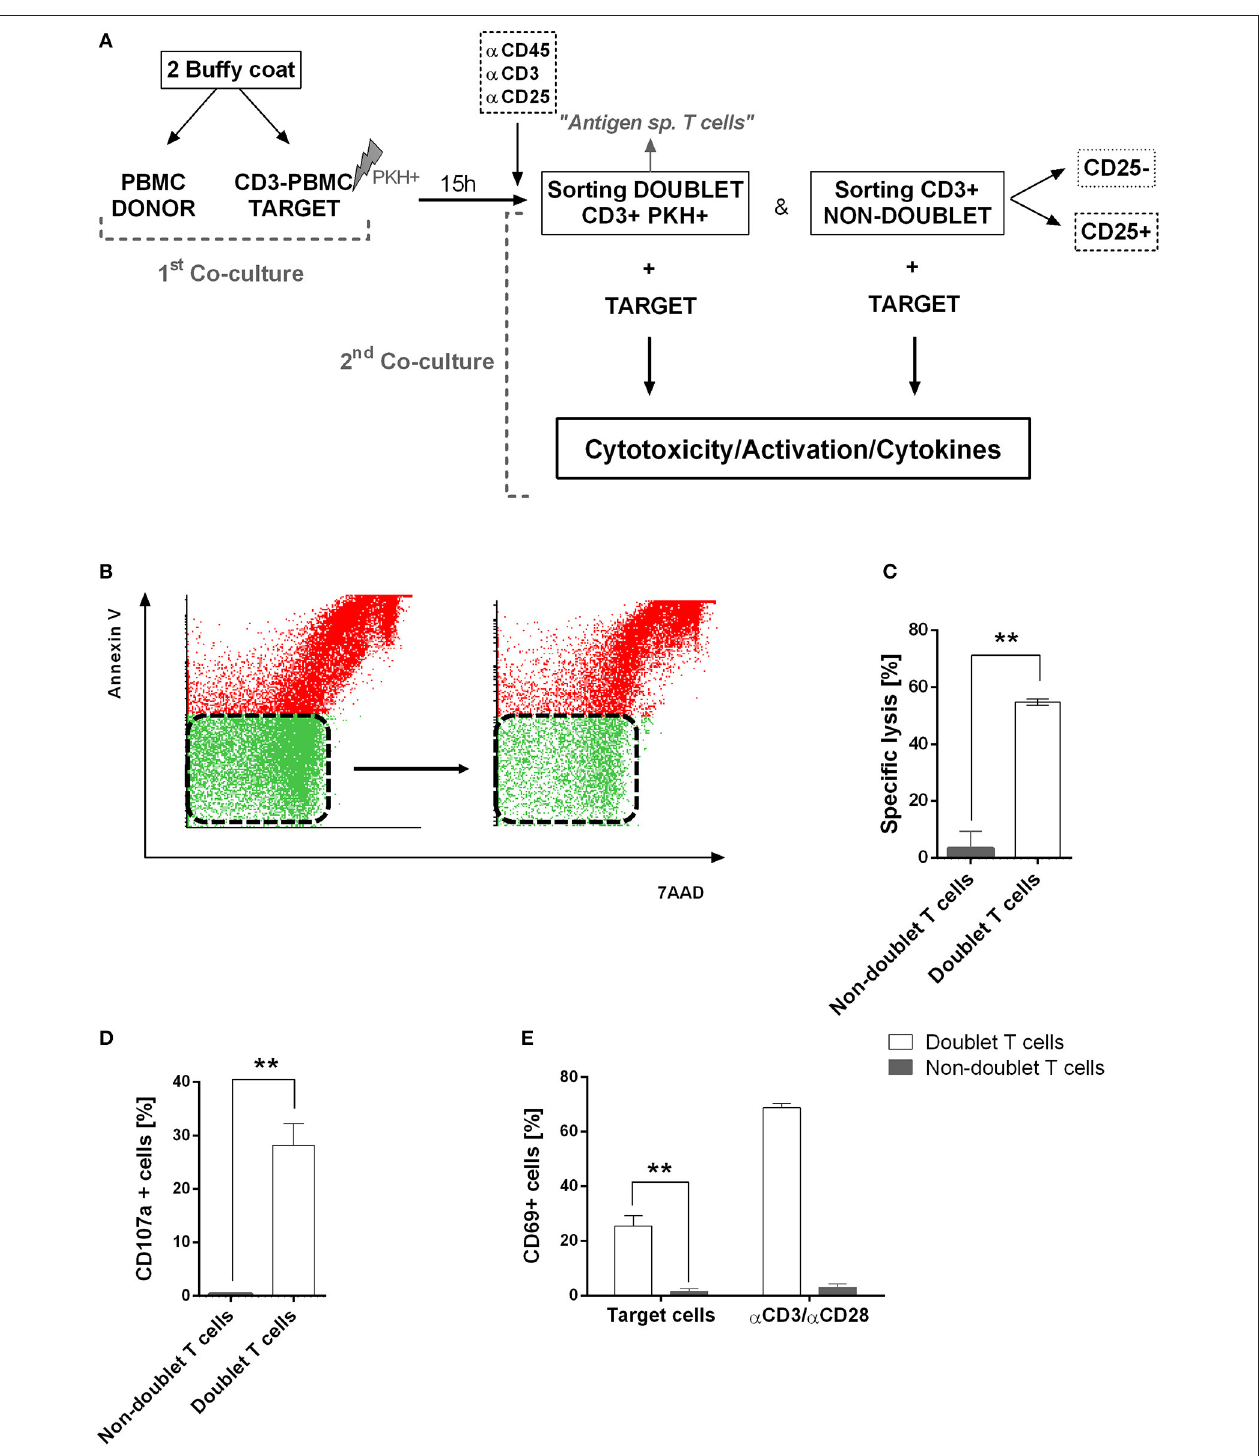
FIGURE 3 | Functional assays of doublet-forming T cells . (A) Schedule of the procedure: PBMC from donor were co-cultured with target PBMC depleted of CD3 cells, irradiated and stained with PKH-67 (first co-culture). After 15h, cells were stained with CD3, CD45, and CD25 monoclonal antibodies for cell sorting. Doublet positive T cells (CD3 + PKH + ) and non-doublet T cells (CD3 + PKH–) were sorted and rested for 20h. Target cells were thawed and stained with PKH-67 and secondary co-cultures between doublet-forming T cells or non-doublet T cells with target cells were performed (second co-culture). After 7h, cells were collected and stained with 7AAD and Annexin V. (B) Dot plots show 7AAD and Annexin V staining of target cells alone (left) or co-cultured with doublet T cells (right) in one case as